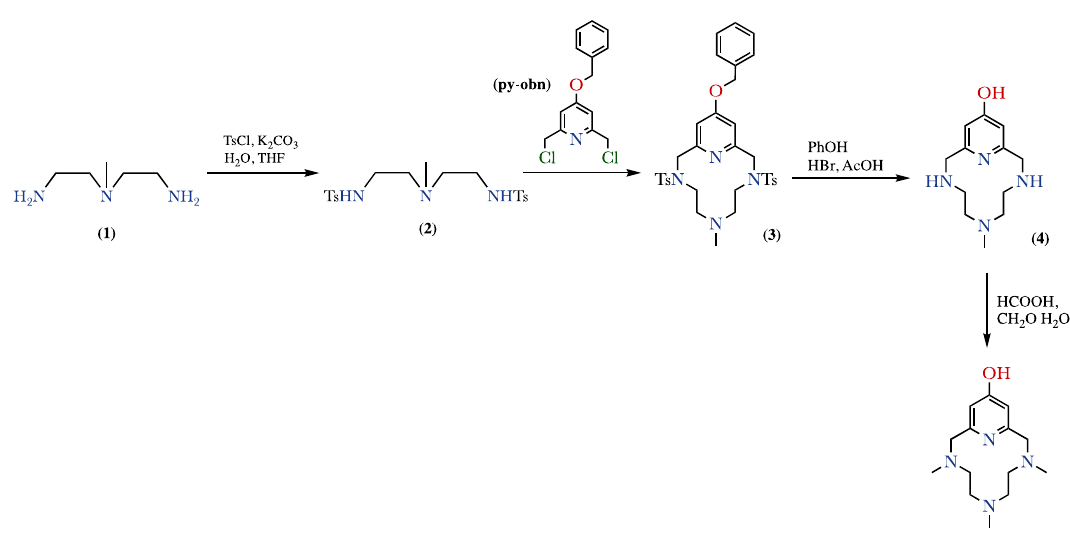
Figure 13. Chemical synthesis of ligand L2–Me 3 from commercially available polyamine 1 and the synthesized pyridine derivative py-obn .